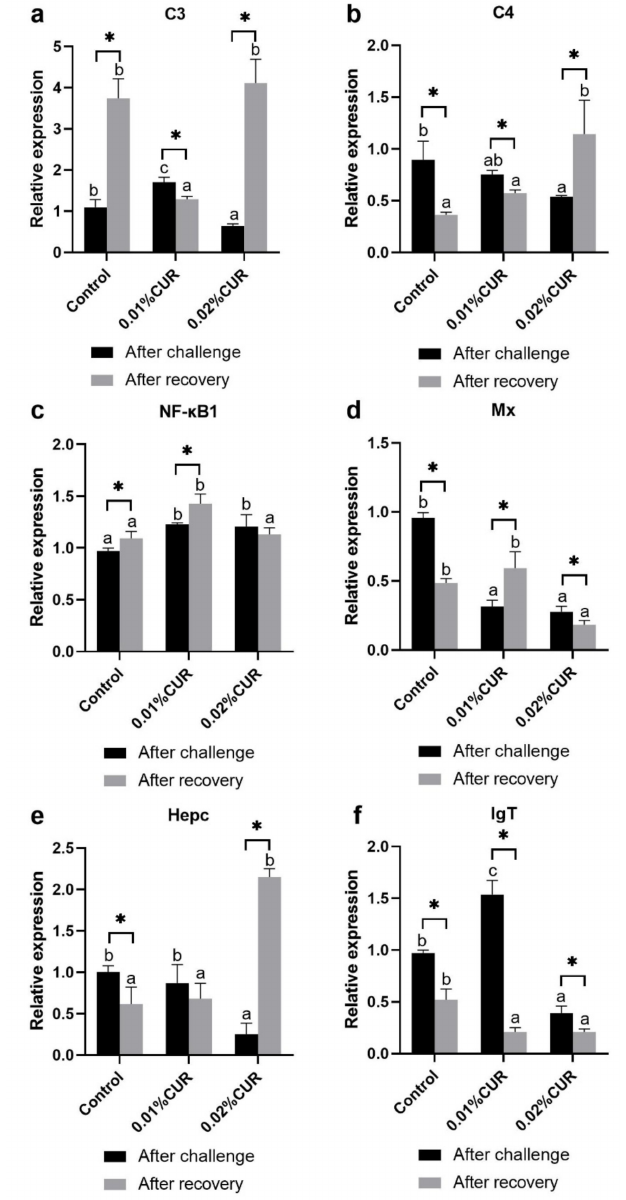
Figure 9. The relative expression of complements ( a ) (C3), ( b ) C4, ( c ) NF- κ B1, ( d ) Mx, ( e ) Hepc and ( f ) lgT genes in intestine of greater amberjack fed with dietary curcumin supplementation. (Different letters above bars and asterisk sign (*) indicate significant differences at the 0.05